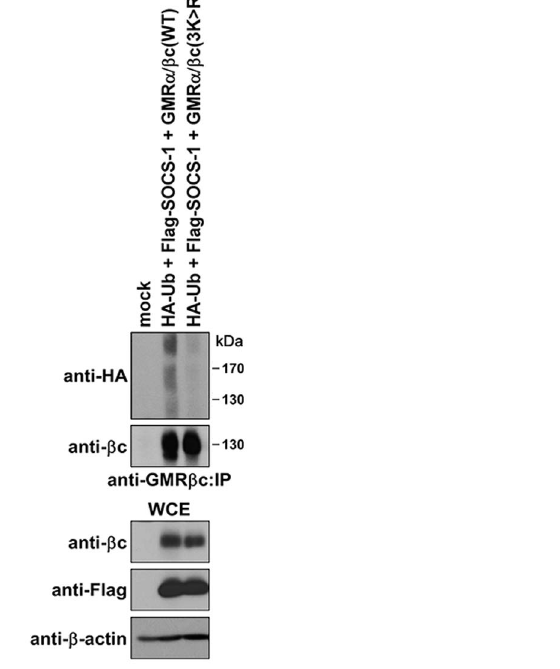
Figure 3. SOCS-1 ubiquitylates GMR b c on K457, K461 and/or K467. HEK293 cells transfected with plasmids encoding GMR a , b c (WT or 3K . R mutant) and HA-ubiquitin (HA-Ub) or empty plasmid (mock) were treated with GM-CSF and MG132 then lysed, immunoprecipitated (IP) using anti-GMR b c antibody, and immunoblotted with the indicated antibodies. WCE: whole cell extract.